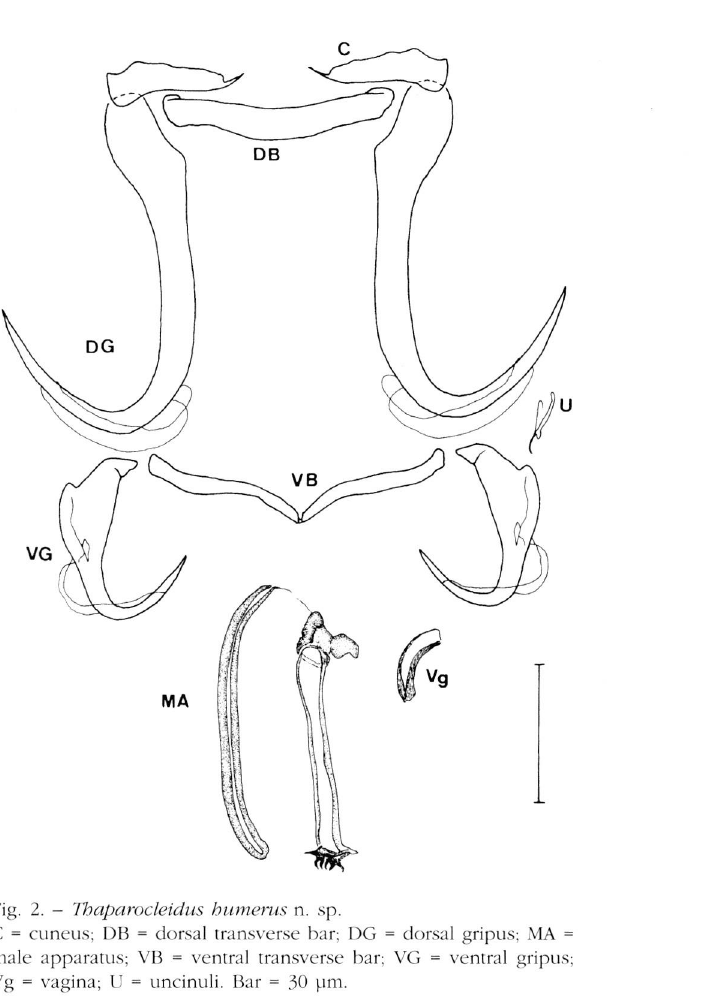
Fig. 2. - Tbaparocleidus humerus n. sp. C = cuneus; DB = dorsal transverse bar; DG = dorsal gripus; MA = male apparatus; VB = ventral transverse bar; VG = ventral gripus: Vg = vagina; U = uncinuli. Bar = 30 um.